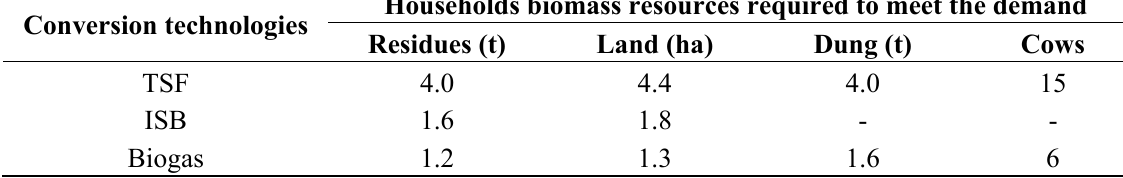
Table 4. Biomass resources required to meet the demand with different energy conversion